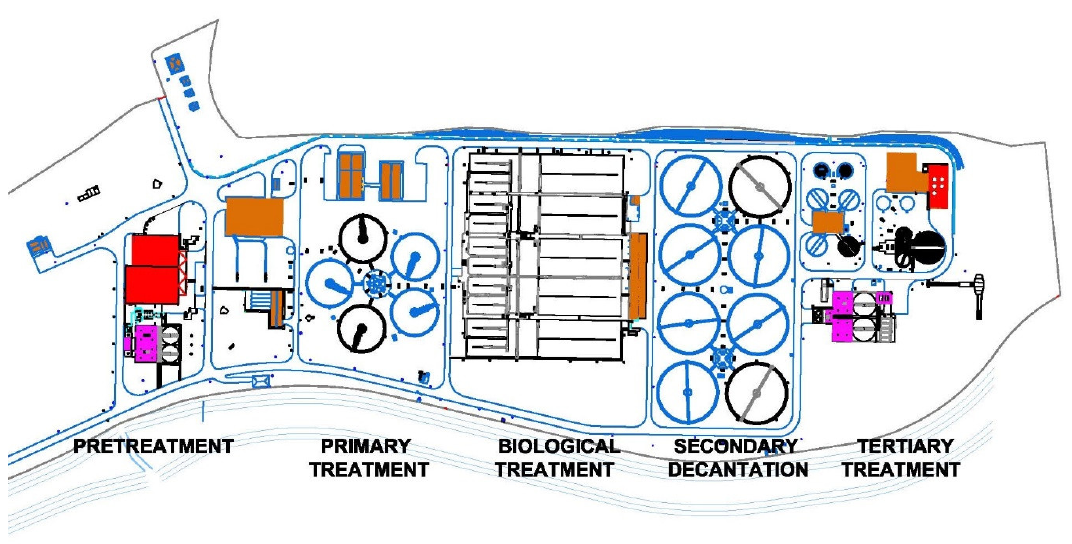
Figure 1. Plan view of the Villap é rez wastewater treatment plant (WWTP) (Asturias, Spain). Figure 1. Plan view of the Villapérez wastewater treatment plant (WWTP) (Asturias, Spain). Figure 1. Plan view of the Villapérez wastewater treatment plant (WWTP) (Asturias, Spain). As can be seen in Figure 2, the wastewater treatment in Villap é rez WWTP begins with The pretreatment section has the capacity to treat an inflow of 8.5 m 3 /s (734.400 a pretreatment stage in which the larger solids, sands, and fats are removed. Subsequently, m 3 /day) and starts with two thick wells, equipped with a 500-litre clamshell bucket (Figure The pretreatment section has the capacity to treat an inflow of 8.5 m 3 /s (734.400 the water is taken to primary settling by gravity. The water then goes to biological treatment 2). The plant then has four roughing channels, each of which includes an automatic clean- m 3 /day) and starts with two thick wells, equipped with a 500-litre clamshell bucket (Figure where organic matter, nitrogen, and phosphorus are removed. This treatment involves the ing screen with a 60 mm clearance and a self-cleaning fines screen with a 3 mm clearance 2). The plant then has four roughing channels, each of which includes an automatic clean- passage of water through several anoxic chambers, anaerobic and aerobic. The next stage and an inclination of 50°. ing screen with a 60 mm clearance and a self-cleaning fines screen with a 3 mm clearance is secondary settling, which is carried out via gravity. Finally, the tertiary treatment stage and an inclination of 50°. consists of a physical–chemical treatment, lamellar settling, and filtration.